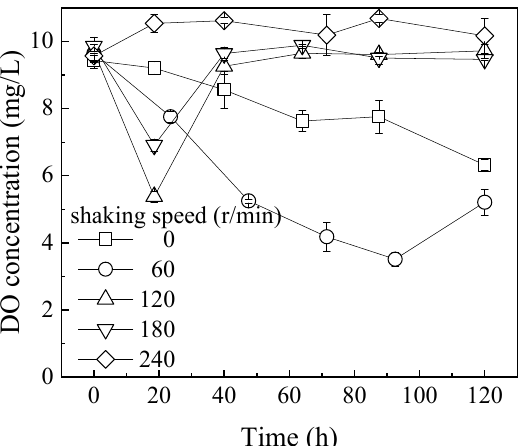
Figure 4. E ff ect of the hydraulic shear force on the DO concentration of the 9K-FeSO 4 - Figure 4. Effect of the hydraulic shear force on the DO concentration of the 9K-FeSO 4 - A. ferrooxidans A. ferrooxidans system.